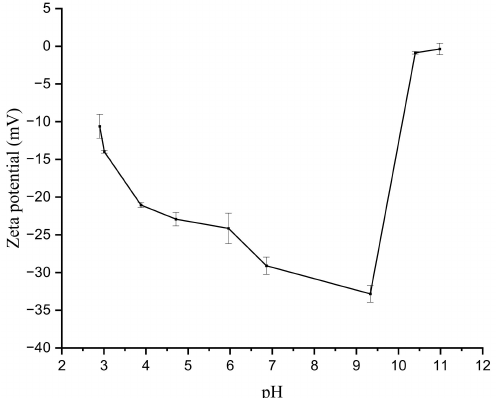
Figure 8. Surface zeta potential values of TiO 2 /GO-Al 2 O 3 HF NF membranes at different pH